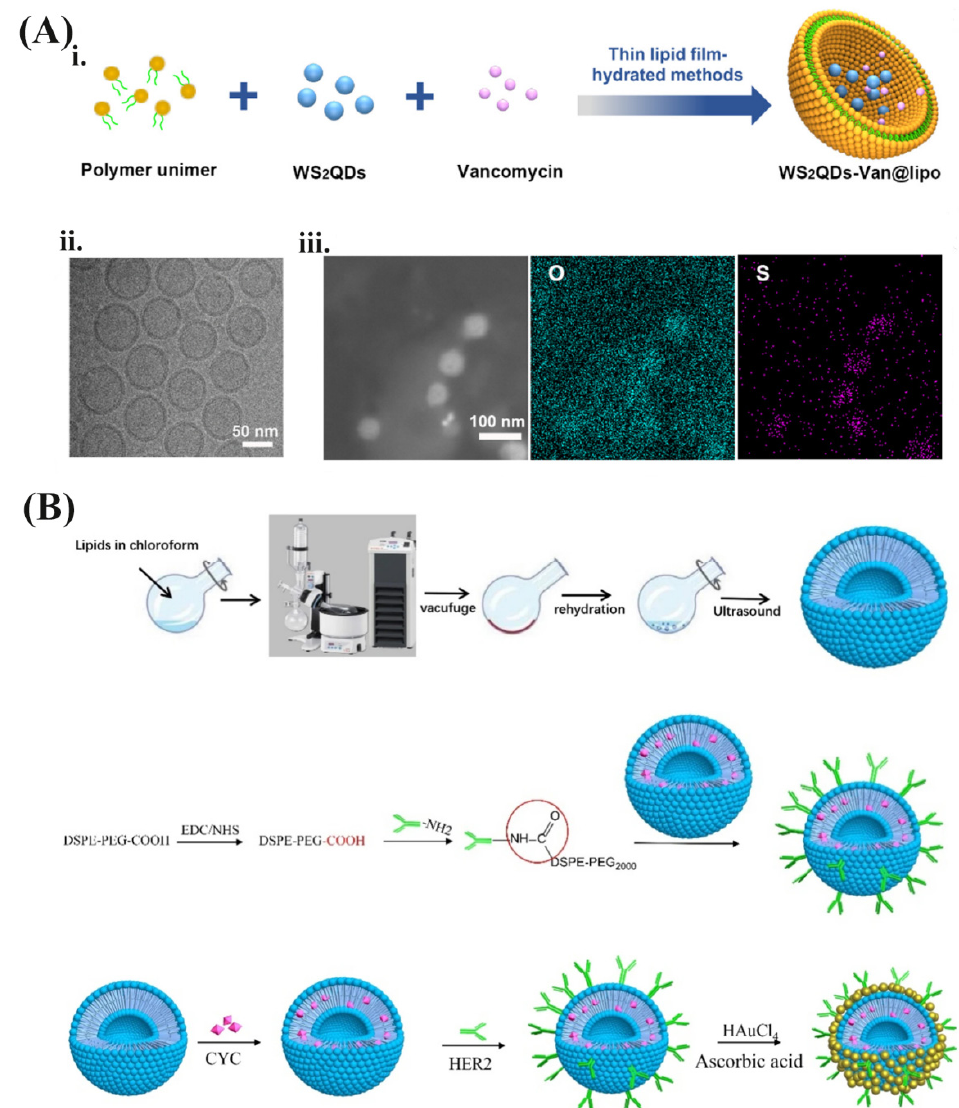
Figure 4. ( A ). ( i ) Schematic illustration of the preparation process of WS2QDs-Van@lipo. ( ii ) Cryo-electron microscopy images of WS2QDs-Van@lipo. Scale bar: 50 nm. ( iii ) Elemental mapping images (O in blue, S in purple) of the WS2QDs-Van@lipo obtained with TEM. Scale bar: 100 nm. Reprinted with permission from [95], American Chemical Society, 2020. ( B ) Illustration of dual-targeting GTSL-CYC-HER2 and its intracellular trafficking pathway in tumor cells. Reprinted with permission from [35], Springer Nature, 2021.